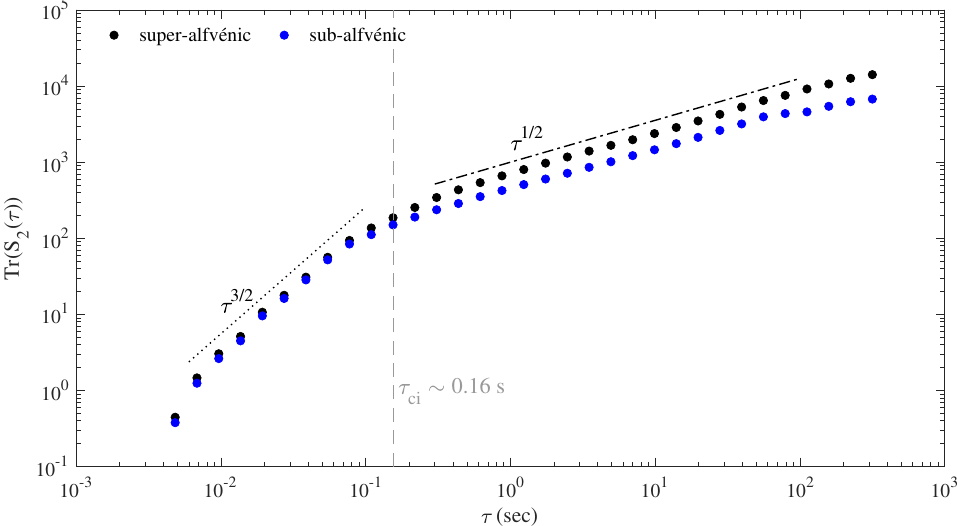
( i ) ( τ ) , for the super-alfvénic 2